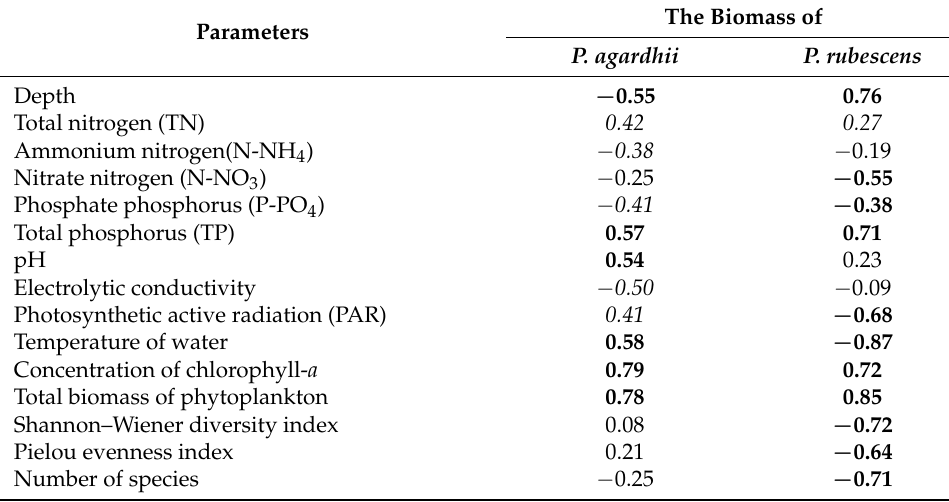
Table 2. Spearman’s rank correlation matrix (r) of Planktothrix agardhii biomass in Lake Glinki ( n = 35) and Planktothrix rubescens biomass in Lake Piaseczno ( n = 65) and selected environmental parameters (bold numerals for p < 0.001; italic numerals for p < 0.05). The Biomass of Parameters P. agardhii P.